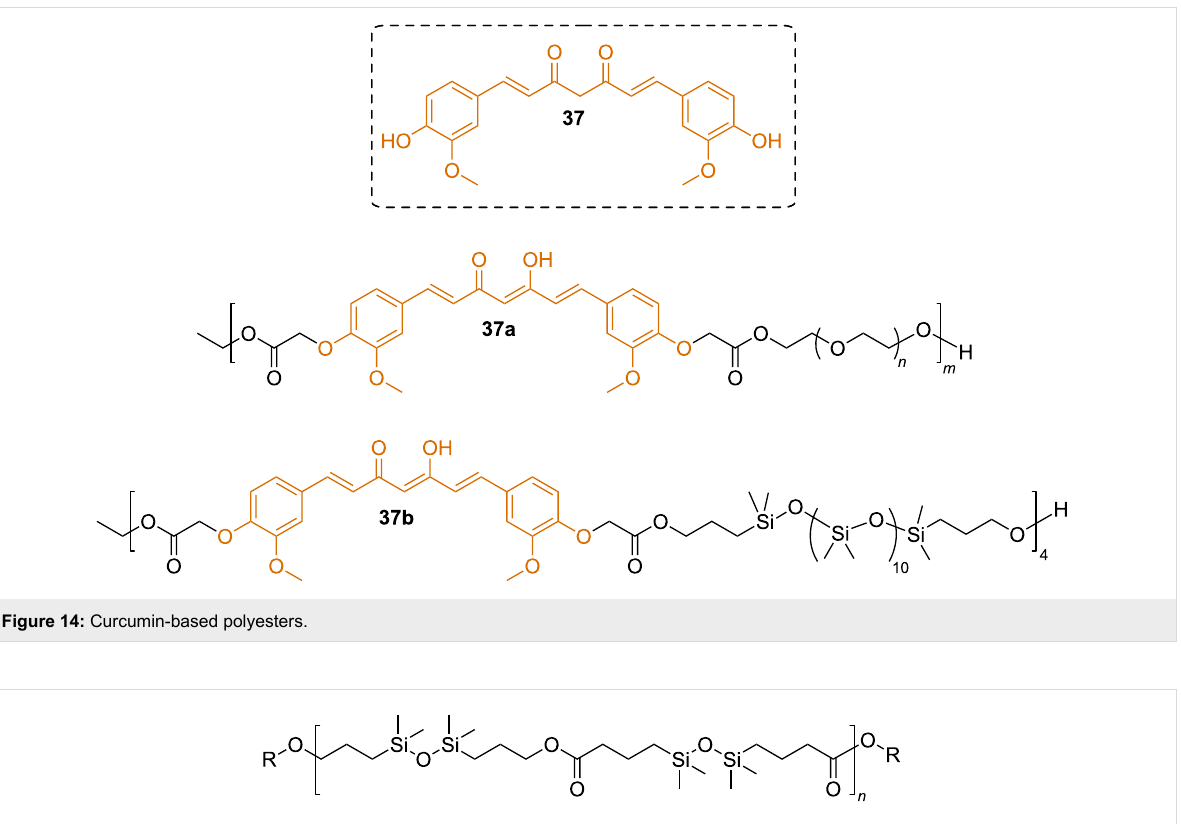
Figure 15: Silylated polyesters.